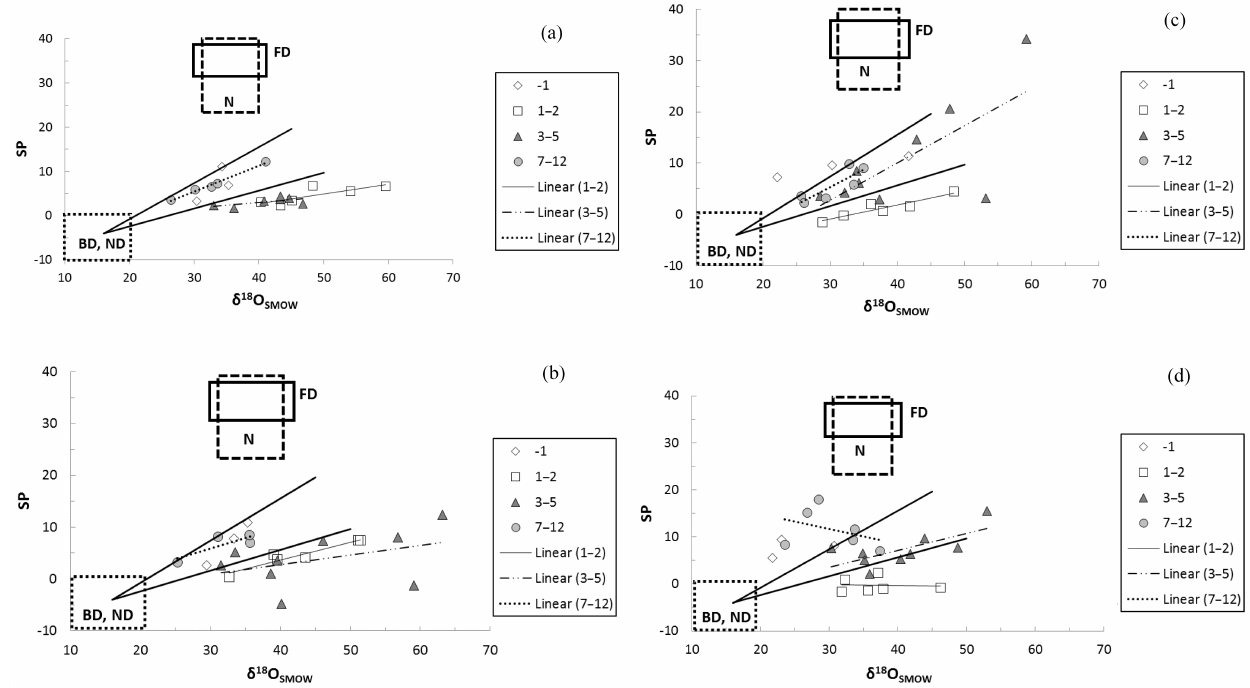
Figure 5. Site preference (‰) vs. δ 18 O (‰) in all treatments for three periods (day − 1, days 1–2 and days 3–12) in the experiment: (a) SAT/sat treatment; (b) HALFSAT/sat; (c) UNSAT/sat; (d) UNSAT/halfsat. Equations of fitted functions and correlation coefficients are in Table 7 for 1–2, 3–5 and 7–12 (5–12 for c ). Endmember areas for nitrification, N; bacterial denitrification, D; fungal denitrification, FD; and nitrifier denitrification, ND, as well as corresponding vectors or reduction lines (black solid lines) are from Lewicka-Szczebak et al. (2017) and represent minimum and maximum routes of isotopocule values with increasing N 2 O reduction to N 2 based on the reported range in the ratio between the isotope fractionation factors of NO reduction for SP and δ 18 O (Lewicka-Szczebak et al.,